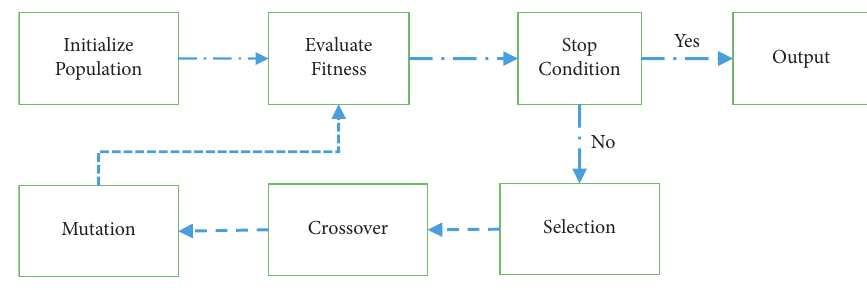
Figure 2: GA flowchart.